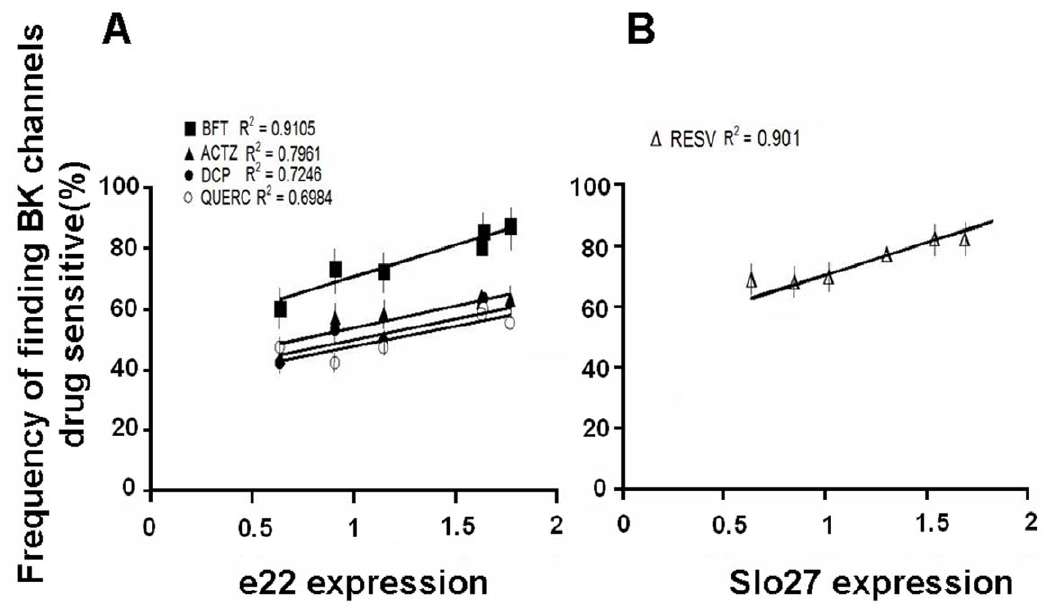
Figure 6. Correlation between the e22 and Slo27 expression levels and drug responses in different muscle phenotypes. The linear regression analysis between the e22 and Slo27 expression levels and the frequency distribution of patches containing Ca 2 + activated K + (BK) channels sensitive to bendroflumethiazide (BFT), acetazolamide (ACTZ), dichlorphenamide (DCP), and quercetin (QUERC) in flexor digitorum brevis (FDB) (A) or resveratrol (RESV) in soleus (Sol) (B) fibers for each muscle sample was performed. The e22 and Slo27 expression levels were normalized to the total BK. The correlation coefficient (R 2 ) is reported for each drug.